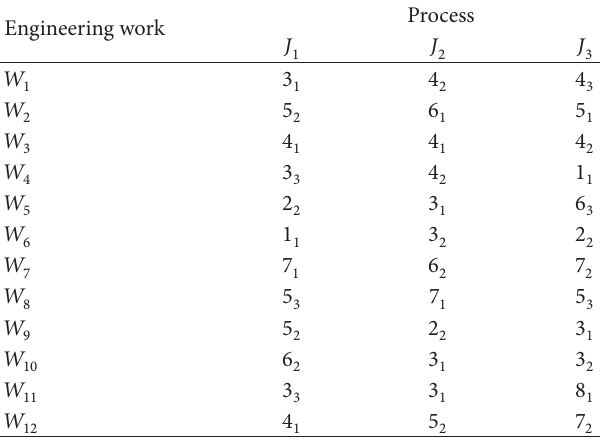
Table 5: Work time of every engineering work and corresponding work group.